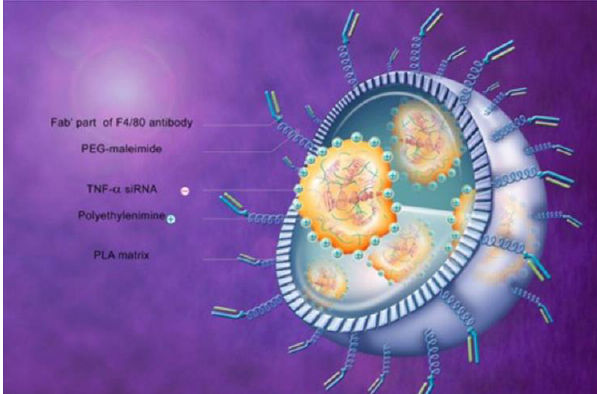
Figure 4. Fab’-siRNA without the chitosan–alginate encapsulation is a nanoparticle of ~375 nm containing siRNA against TNF-α bearing the antigen-binding fragment (Fab’) of the F4/80 antibody, which is specific for murine macrophages. Abbreviations: PLA—polylactic acid; PEG—polyethylene glycol. Reprinted from Laroui et al. [143] with permission from Elsevier.